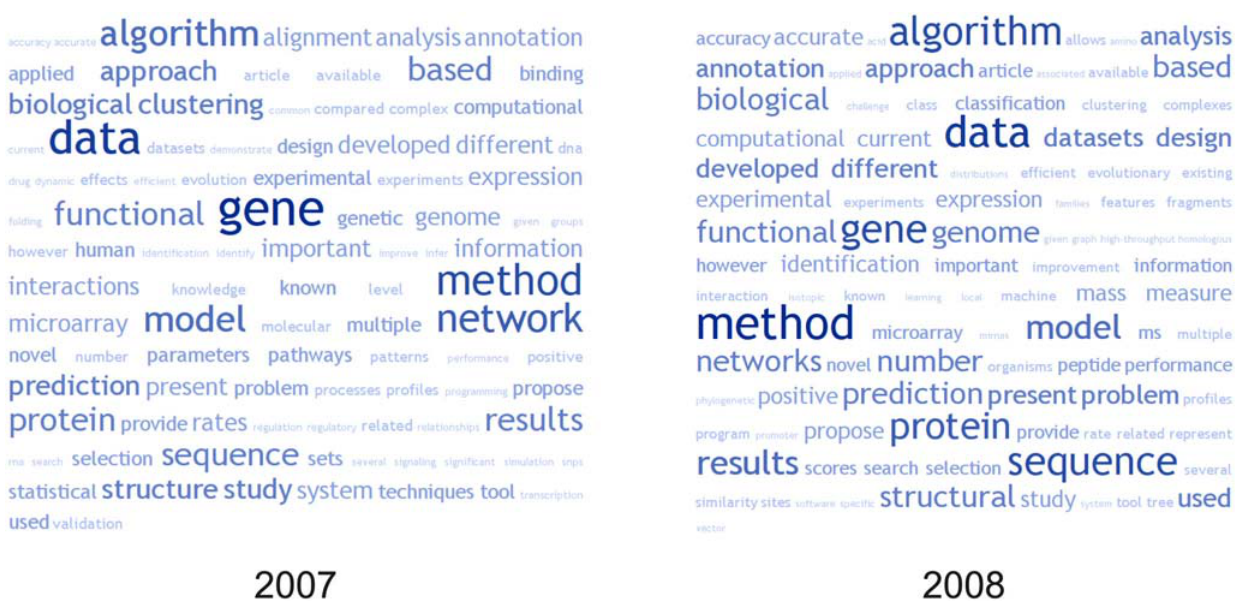
Figure 2. Word cloud analysis of the Proceedings abstracts from ISMB/ECCB 2007 (left) and ISMB 2008 (right)